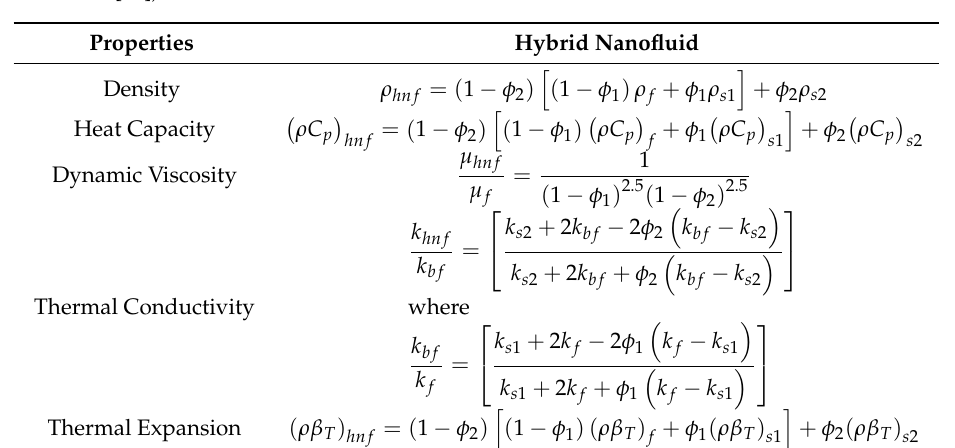
Rostami et al. [34]).